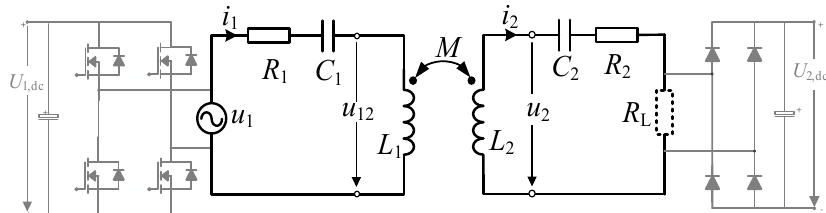
Figure 1. Structure diagram of the magnetically coupled resonant wireless power transfer (MCR-WPT) system with series–series (SS) topology.